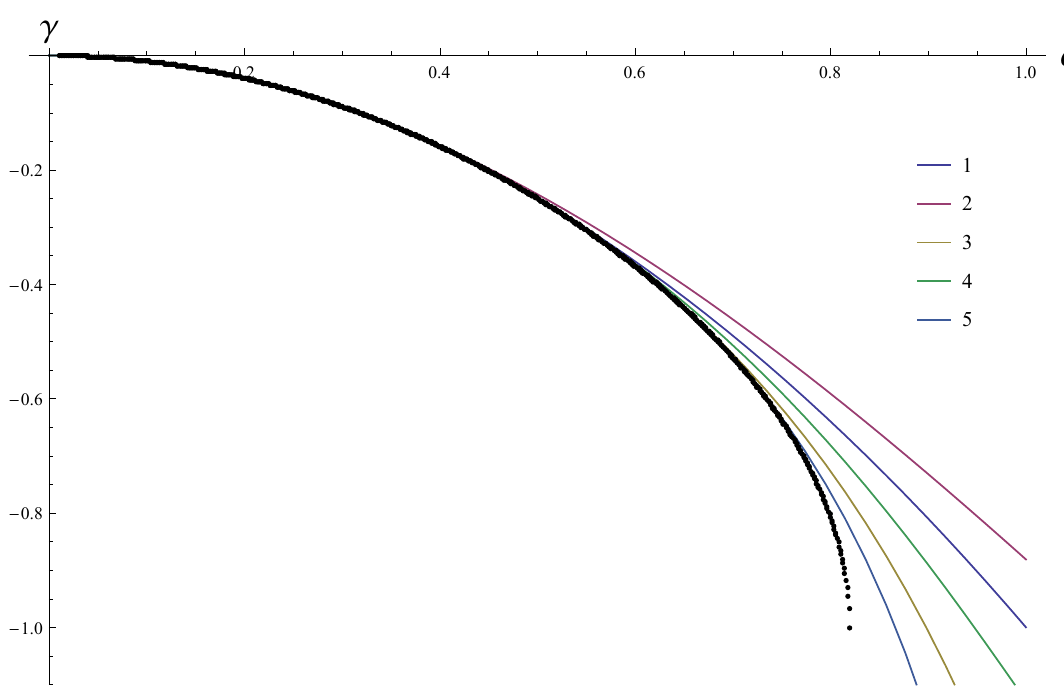
Figure 10 . Convergence of the perturbative expansion to the exact result for the anomalous dimension (cid:13) 11 . The thin lines correspond to truncated sums of the perturbative expansion at the orders indicated in the legend. The thick black dots are numerical evaluations of the re-summed result.